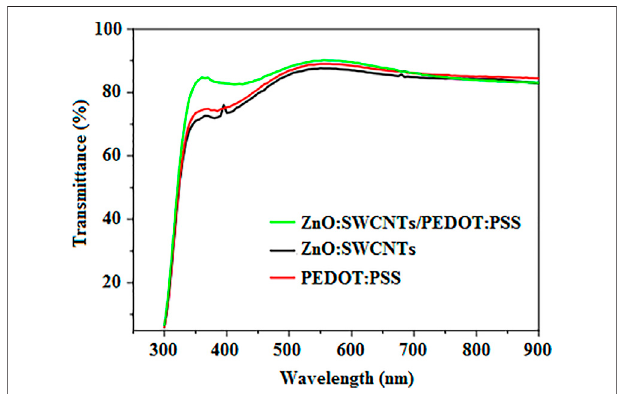
FIGURE 9 | J-V characteristics of OSCs based on af-MWCNTs and c-MWCNTs. Adapted with permission (Zhang et al., 2019). Copyright 2019,